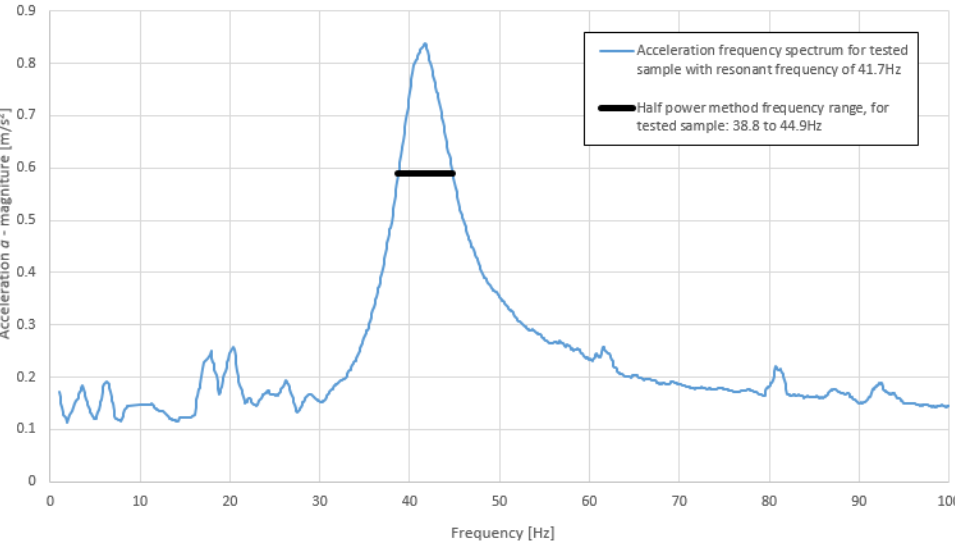
Figure 6. Acceleration frequency response spectrum of an example sample with indication of half- power frequency range (own elaboration).